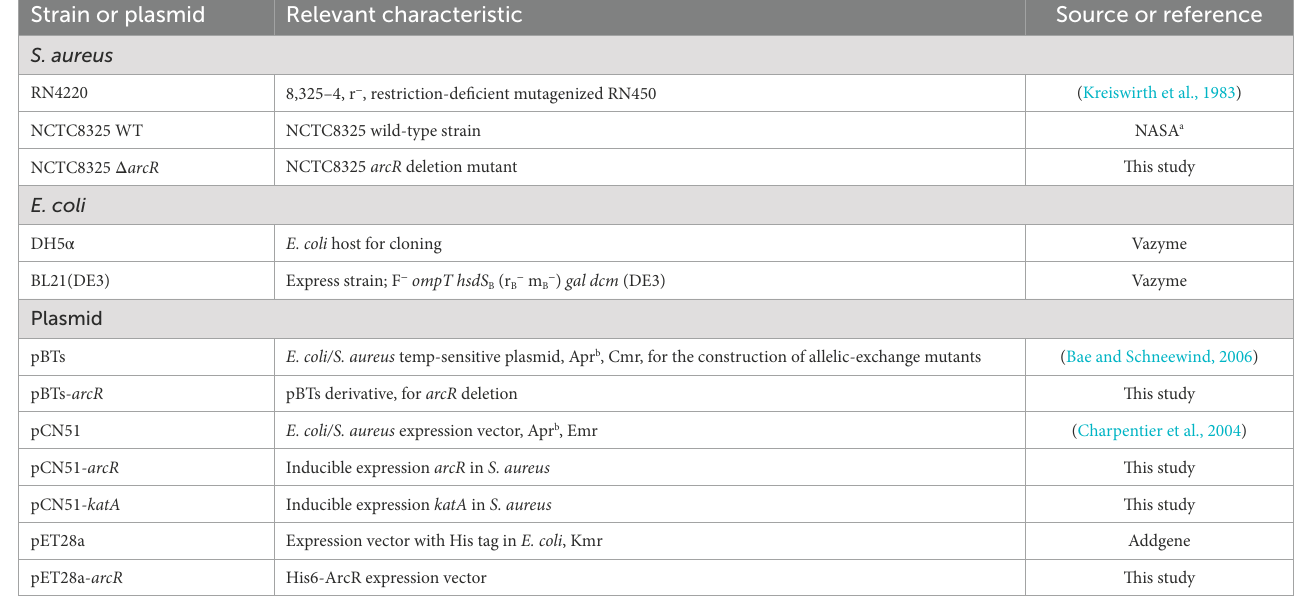
TABLE 1 Bacterial strains and plasmids used in this study. Strain or